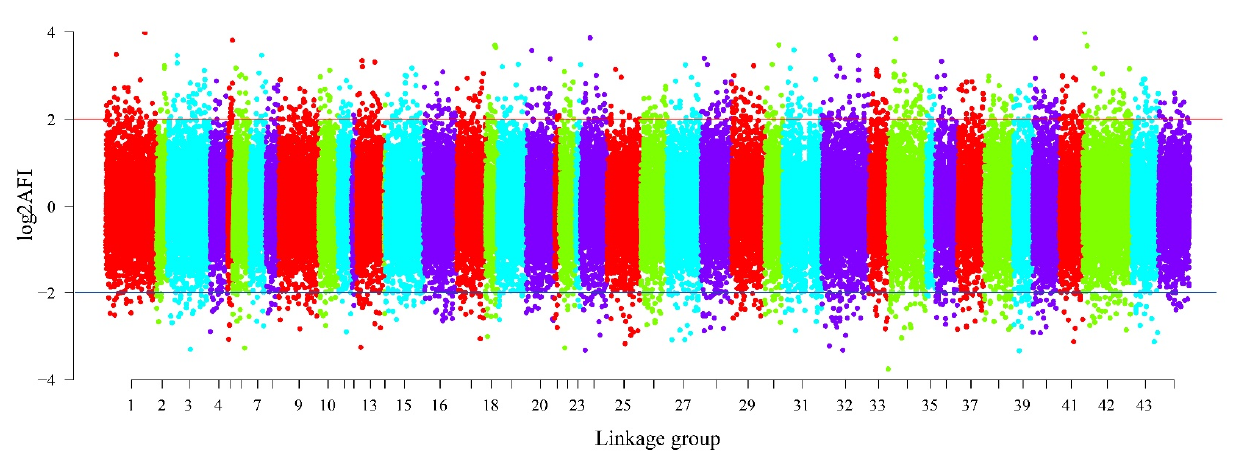
Figure 3. The AFI distribution of 100,633 putative SNPs in linkage groups.